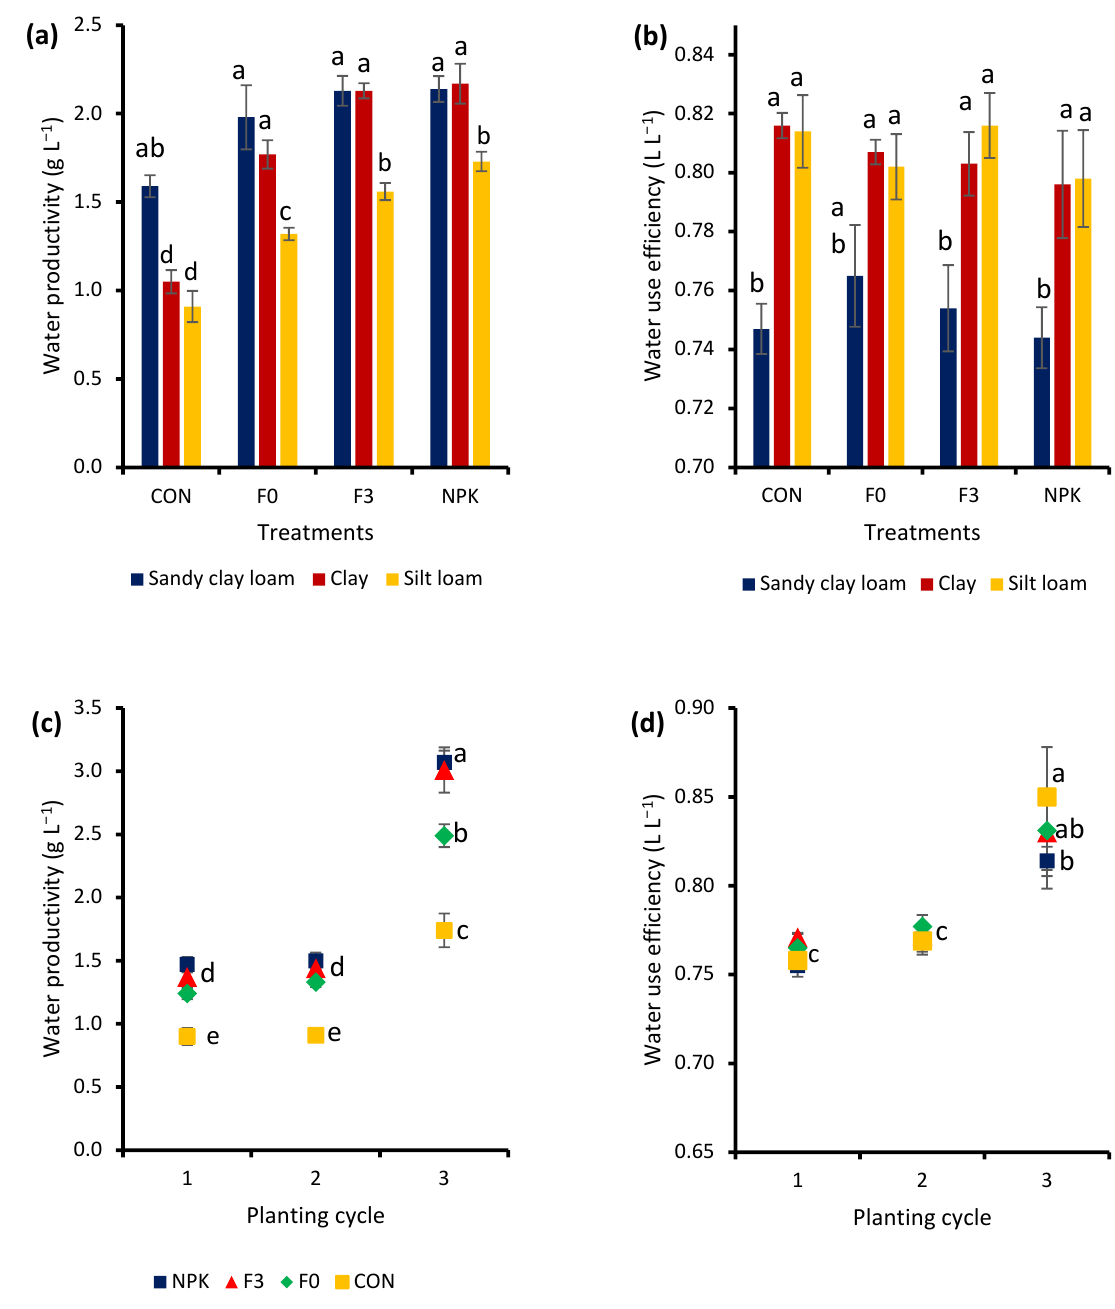
Figure 8. Means ( ± SE) of interaction between soil types and treatments on WP ( a ), WUE ( b ), and interaction between treatments and planting cycle on WP ( c ) and WUE ( d ). Within the same chart, means followed by the same letter are not significantly different ( p > 0.05) from one another using Tukey’s test.